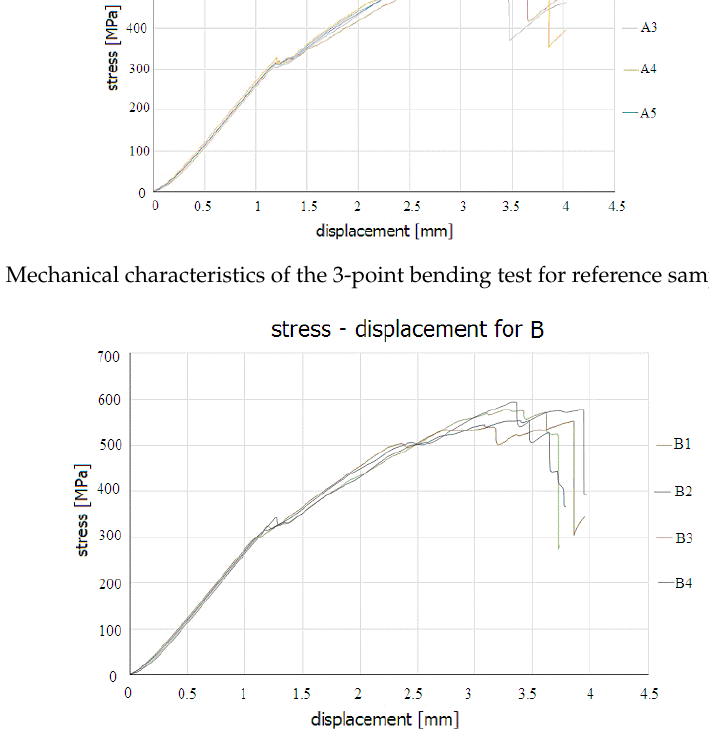
Figure 6. Mechanical characteristics of the 3-point bending test for samples subjected to temperature—group B.